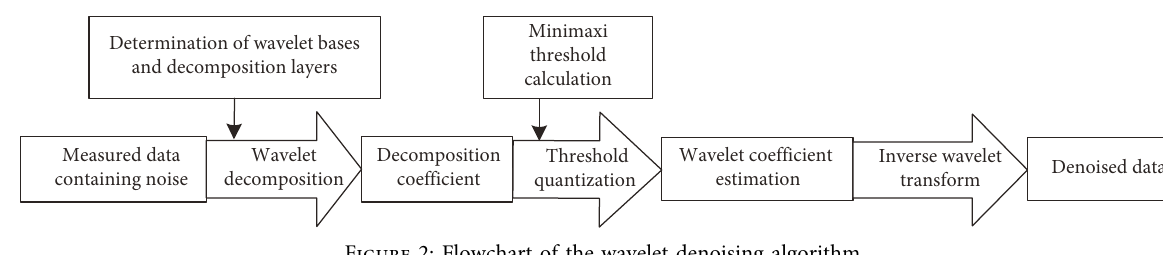
Figure 2: Flowchart of the wavelet denoising algorithm.